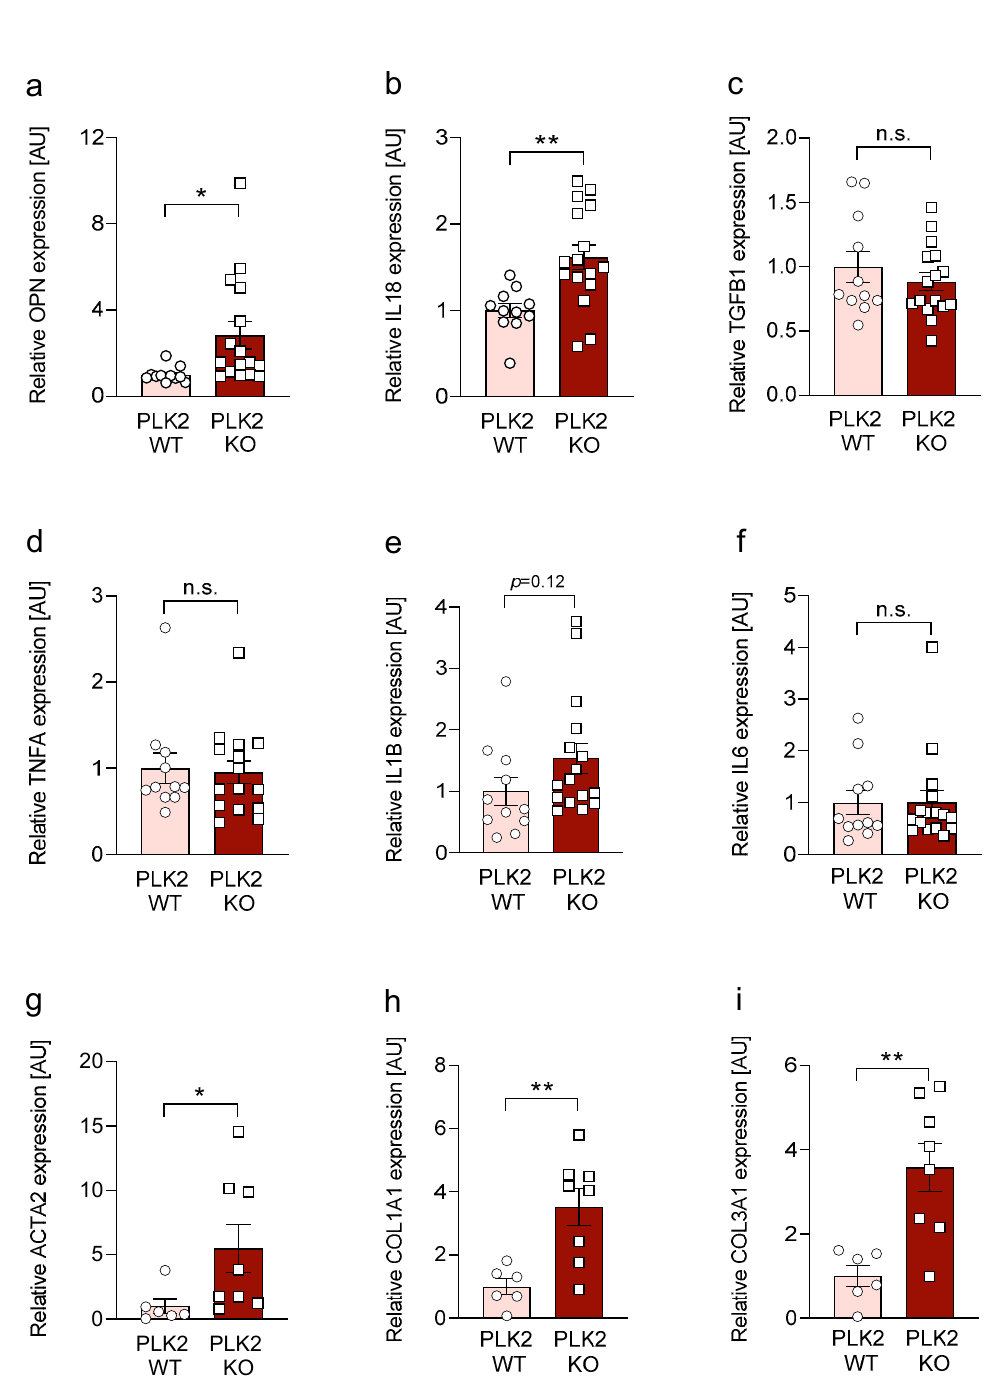
Figure 2. Analysis of pro-fibrotic gene expression with RT qPCR in PLK2 WT and KO lung specimens. ( a ) Quantification of OPN gene expression in PLK2 WT and KO lung tissue normalized to WT ( n WT = 11, n KO = 16). ( b ) Quantification of IL18 gene expression in PLK2 WT and KO lung tissue normalized to WT ( n WT = 11, n KO = 16). ( c ) Quantification of TGFB1 gene expression in PLK2 WT and KO lung tissue normalized to WT ( n WT = 11, n KO = 16). ( d ) Quantification of TNFA gene expression in PLK2 WT and KO lung tissue normalized to WT ( n WT = 11, n KO = 16). ( e ) Quantification of IL1B gene expression in PLK2 WT and KO lung tissue normalized to WT ( n WT = 11, n KO = 16). ( f ) Quantification of IL6 gene expression in PLK2 WT and KO lung tissue normalized to WT ( n WT = 11, n KO = 16). ( g ) Quantification of ACTA2 ( α SMA) gene expression in PLK2 WT and KO lung tissue normalized to WT ( n WT = 6, n KO = 8). ( h ) Quantification of COL1A1 gene expression in PLK2 WT and KO lung tissue normalized to WT ( n WT = 6, n KO = 8). ( i ) Quantification of COL3A1 gene expression in PLK2 WT and KO lung tissue normalized to WT ( n WT = 6, n KO = 8). * p < 0.05. ** p < 0.01. n.s. = not significant.